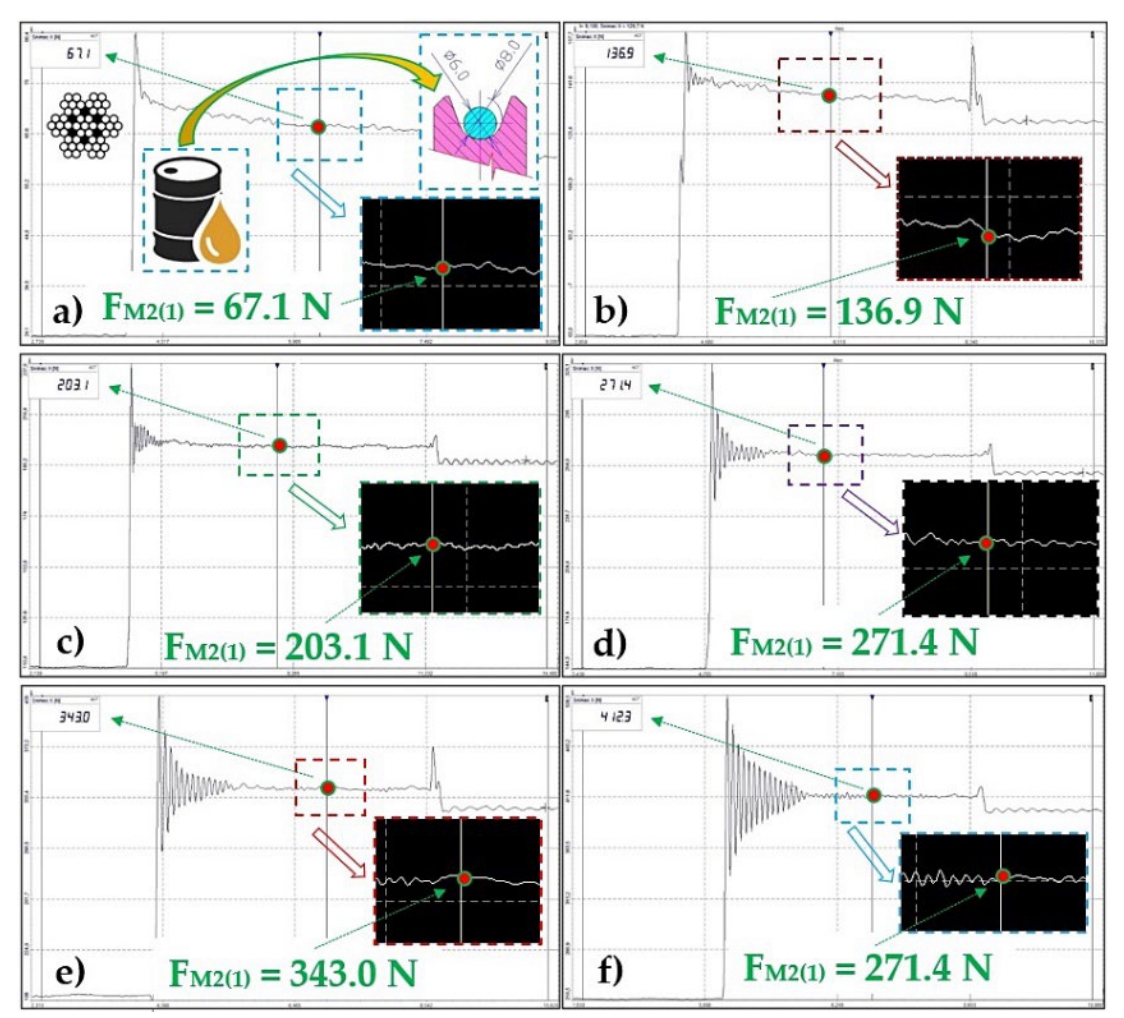
Figure 6. Measured tensile forces F M2(i) [N] for ϕ6 mm rope, semi-circular groove, contaminated with oil (for weight of weights G z [N] ( a ) 49 N, ( b ) 98 N, ( c ) 147 N, ( d ) 196 N, ( e ) 245 N, ( f ) 294 N). 3.4. Tensile Force in ϕ8 mm Rope, Semi -circular Groove, Surface Contaminated with Oil Table 6 shows values measured for tensile forces F M2(i) [N] in rope side 5 (d L = 8 mm) approaching the rope sheave 4, of which the semi-circular groove is dirty with oil. Table 6. Tensile force F M2(i) [N], ϕ8 mm rope, semi-circular groove, contaminated with oil.